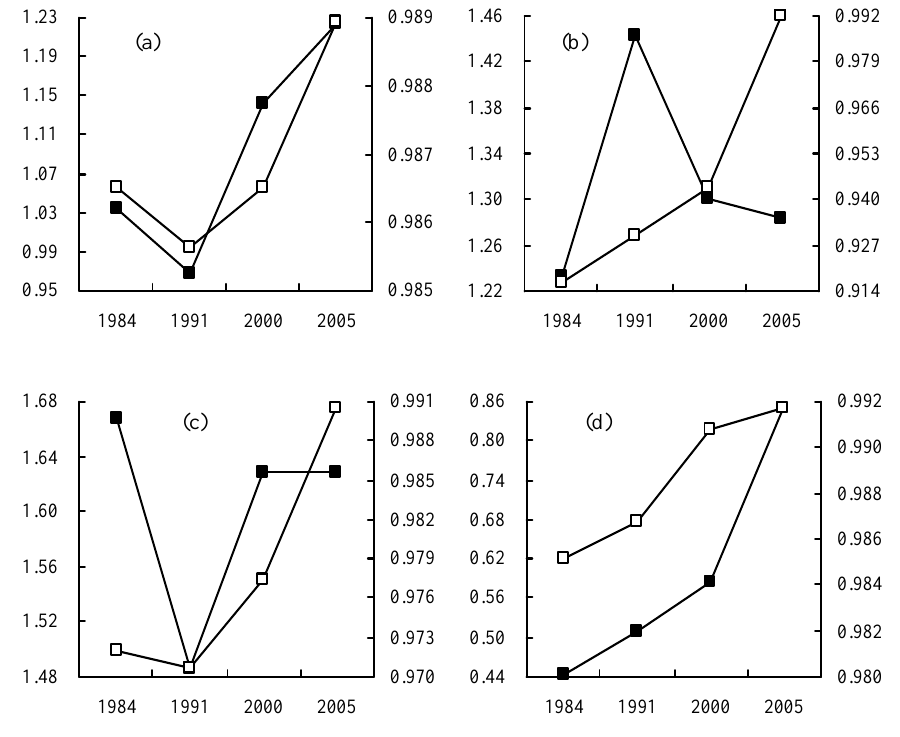
Figure 4. Global fractal radius dimensions and their corresponding correlation coefficients centered at: (a) barycenter, (b) Suzhou, (c) Wuxi, and (d) Changzhou; left y- axis and solid black rectangle for dimension (dimensionless), right y-axis and hollow white rectangle for correlation coefficient (dimensionless), x -axis for time (in